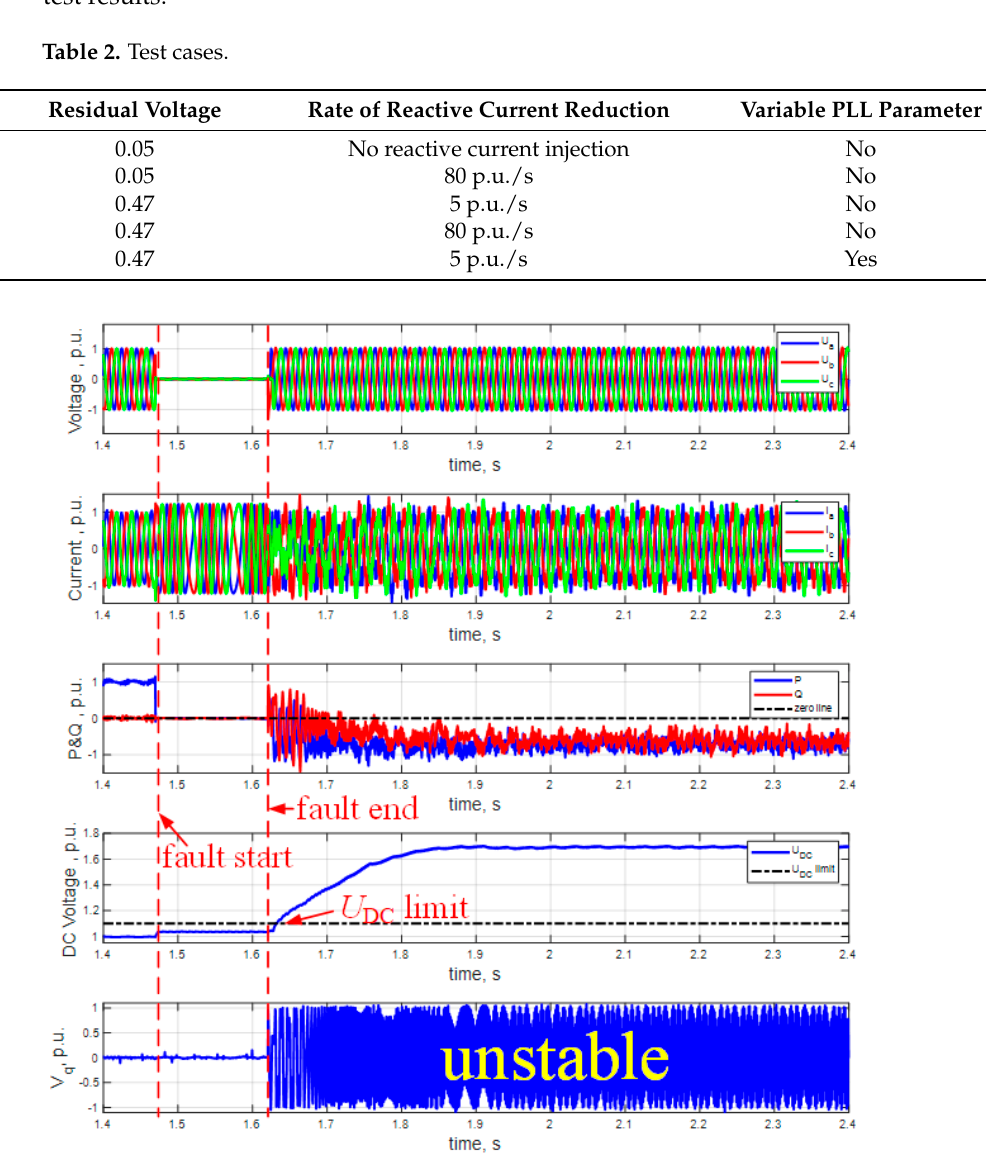
Figure 11. No reactive current injection; the SEP was not present when the fault persisted, resulting in the operating point not being located within the DOA after the fault, and therefore the system being unstable. This led to a reversal of the actual active and reactive power flow (PQ curves are below the black dashed line), resulting in an uncontrolled increase in DC voltage, with the DC voltage curve far above the upper limit (black dashed line).